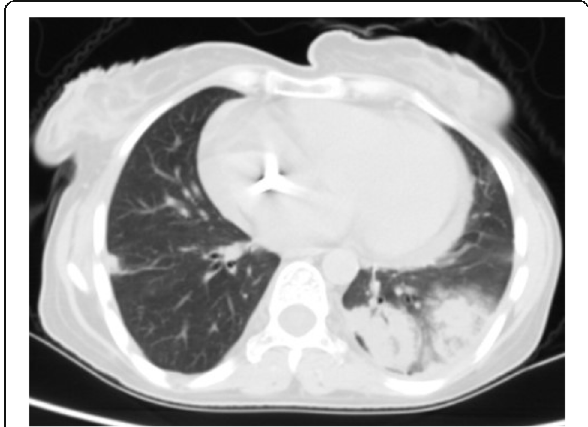
Fig. 16 Angioinvasive aspergillosis represented by halo: thin section